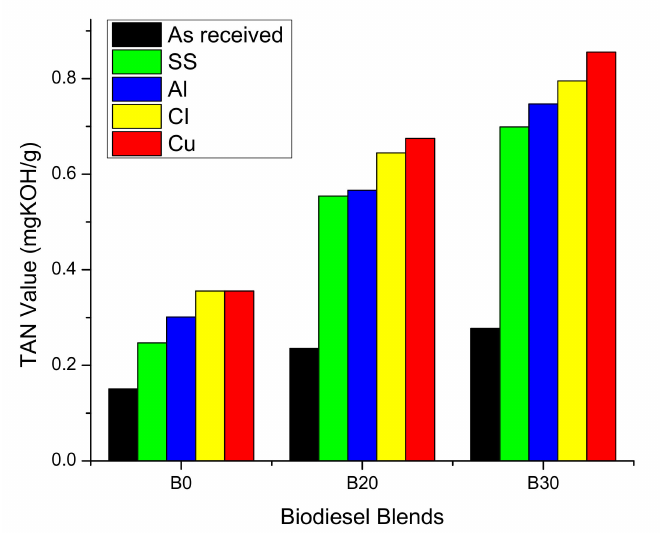
Figure 10. Change in TAN value of biodiesel after the immersion test with different